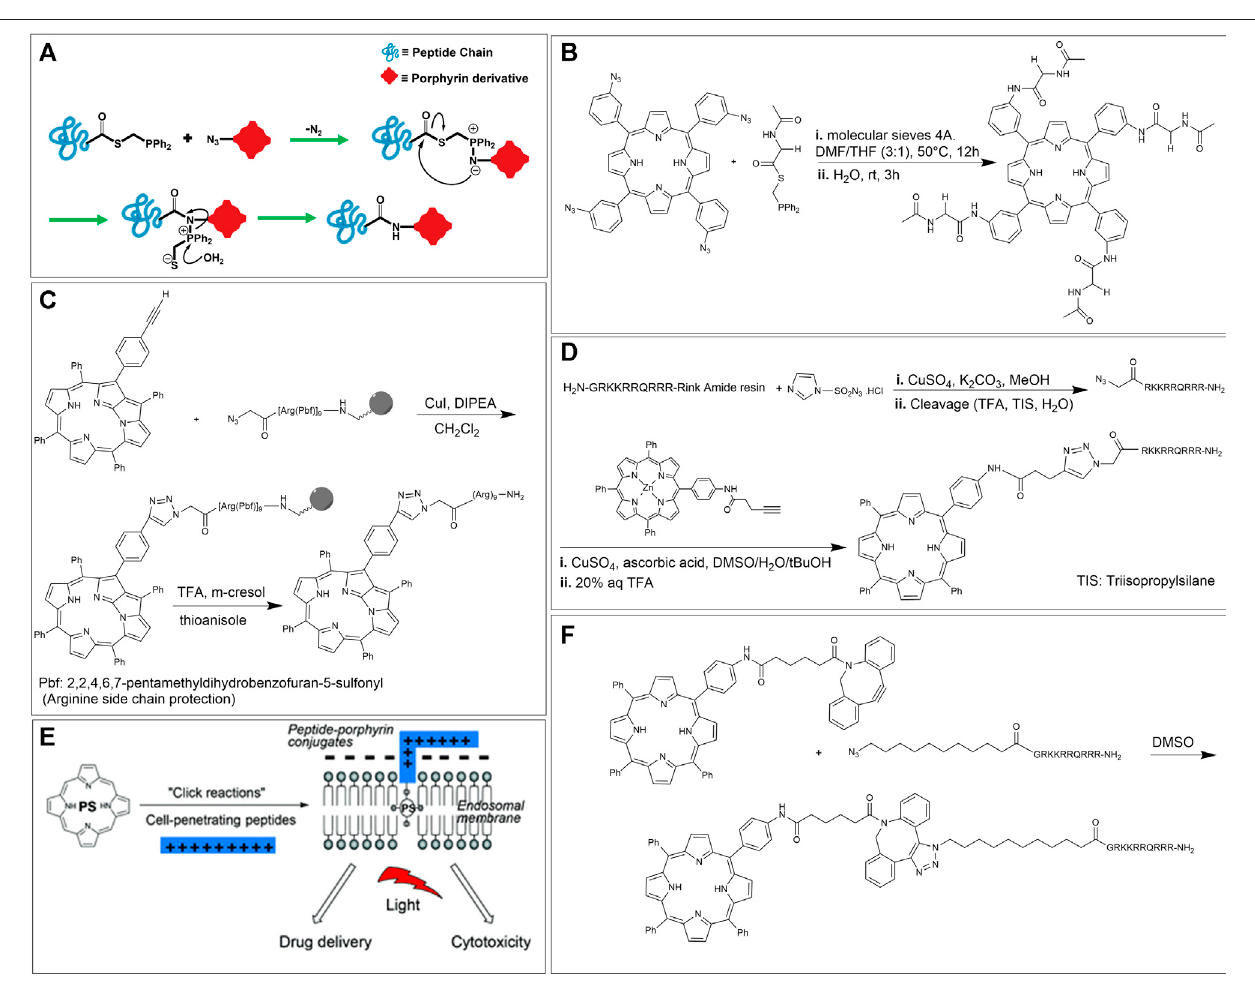
FIGURE 7 | (A) Traceless Staudinger ligation mechanism. (B) Scheme for conjugation of 5,10,15,20-tetrakis (3-azidophenyl) porphyrin with a phosphine tethered aminoacidthroughStaudinger ligation(Umezawa etal., 2010). (C) ConjugationofN-fusedtetraphenylporphyrin and nona-arginine peptide byCuAACon solidsupport, followedbyacidcleavagefromtheresin(Ikawaetal.,2009). (D) CuAACbasedbioconjugationofamono-alkynefunctionalizedTPPwiththecorrespondingCPPpeptide. (E) Schematic of PCI using an amphiphilic CPP-targeted photosensitizer. The hydrophobic photosensitizer core localizes inside the lipid bilayer of endosomal/ lysosomal vesicles while the cationic peptide resides on the exterior. Reprinted with permission from (Dondi et al., 2016). (F) Scheme for conjugation of strained alkyne functionalized porphyrins to the corresponding CPP derivative via SPAAC (Dondi et al., 2016).